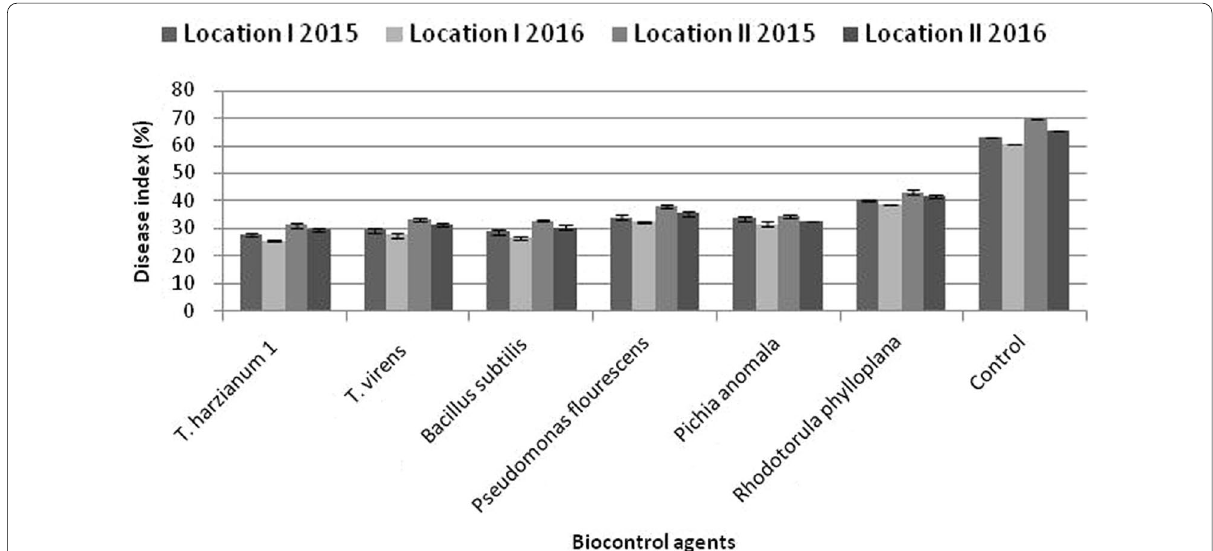
Fig. 5 Effect of bio-control agents on anthracnose development on mango leaves under field